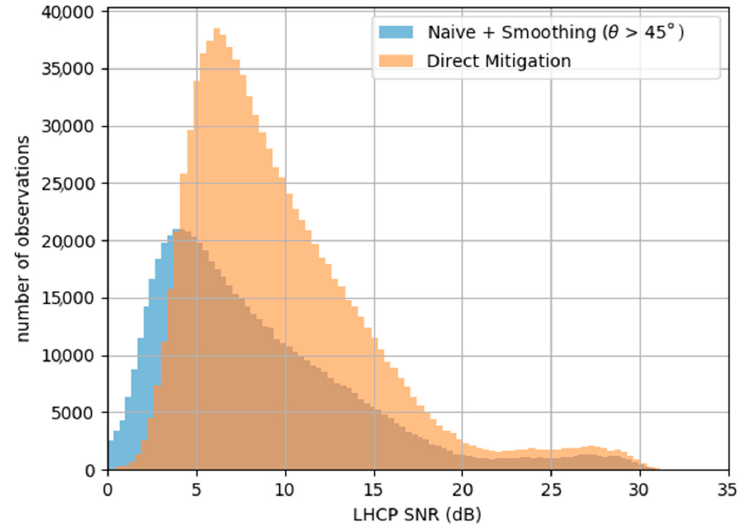
Figure 16. Data availability vs. SNR for the filtered original dataset (blue) and for the reprocessed dataset (orange).